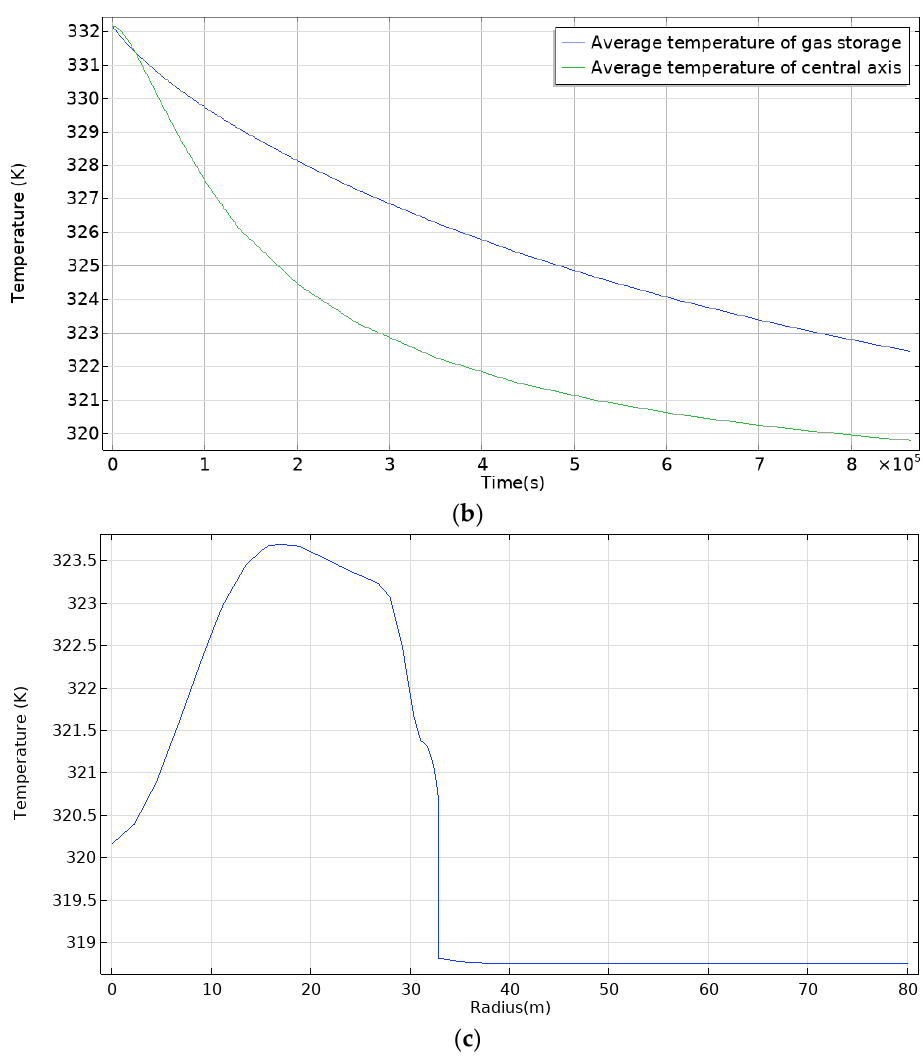
Figure 17. Temporospatial distribution of temperature for 10-day withdrawal operation: ( a ) 3-D view of temperature distribution; ( b ) temperature at centerline and average temperature over 10 days; ( c ) average temperature at a depth of 1030 m.